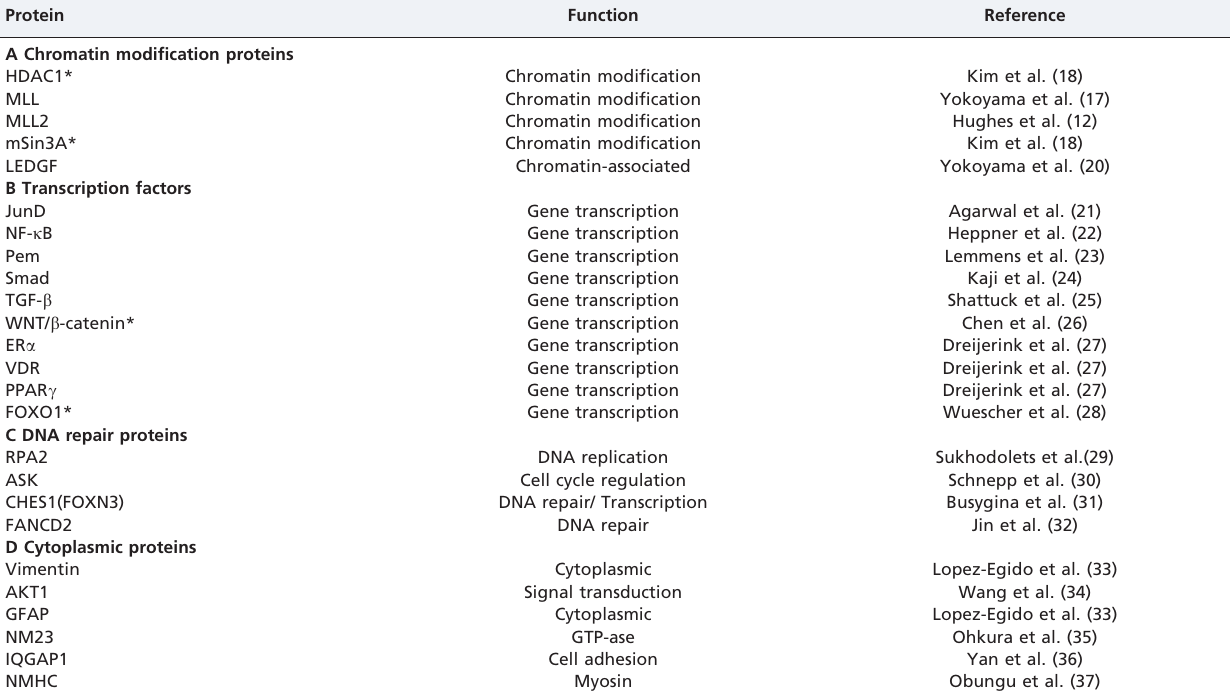
Table 1 - Menin-interacting